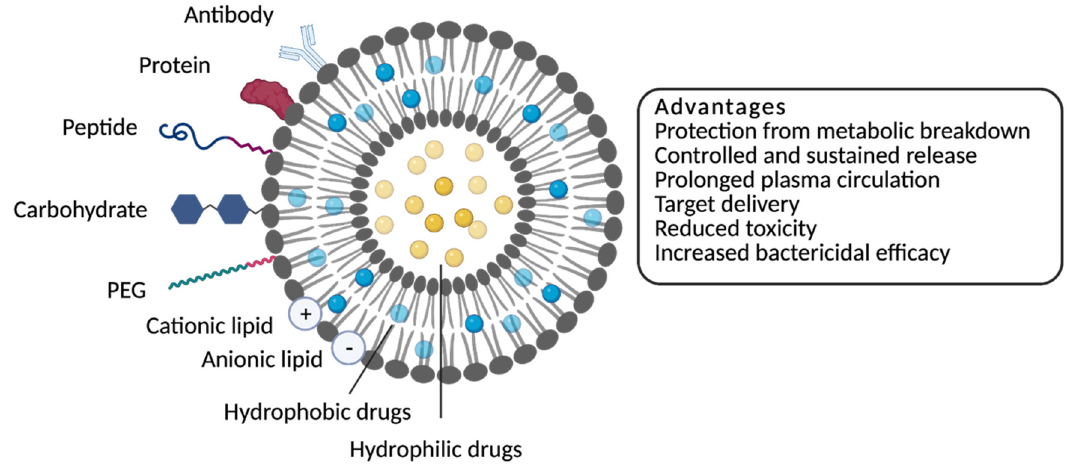
Figure 1. Schematic representation of different types of liposomes and their major advantages.